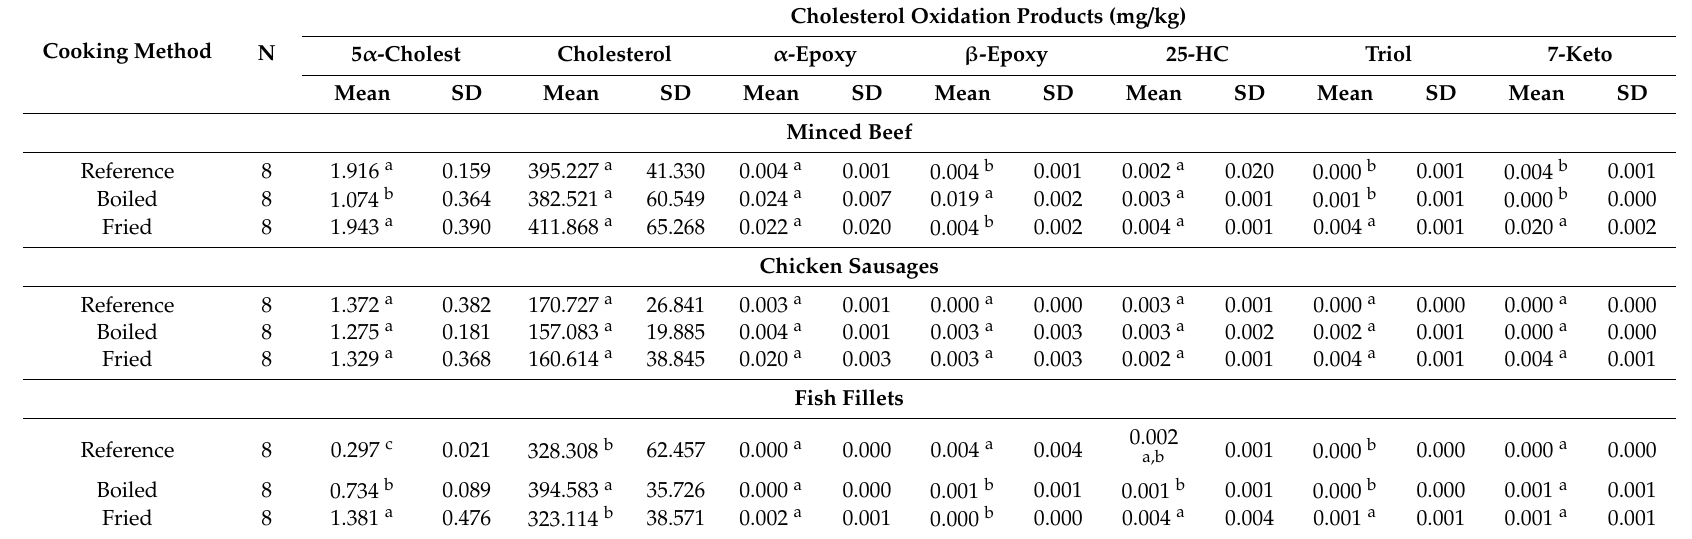
Table 1. Comparison of COP mean (ppm) in minced beef, chicken sausages, and fish fillets for three methods of treatment (raw, boiled, and